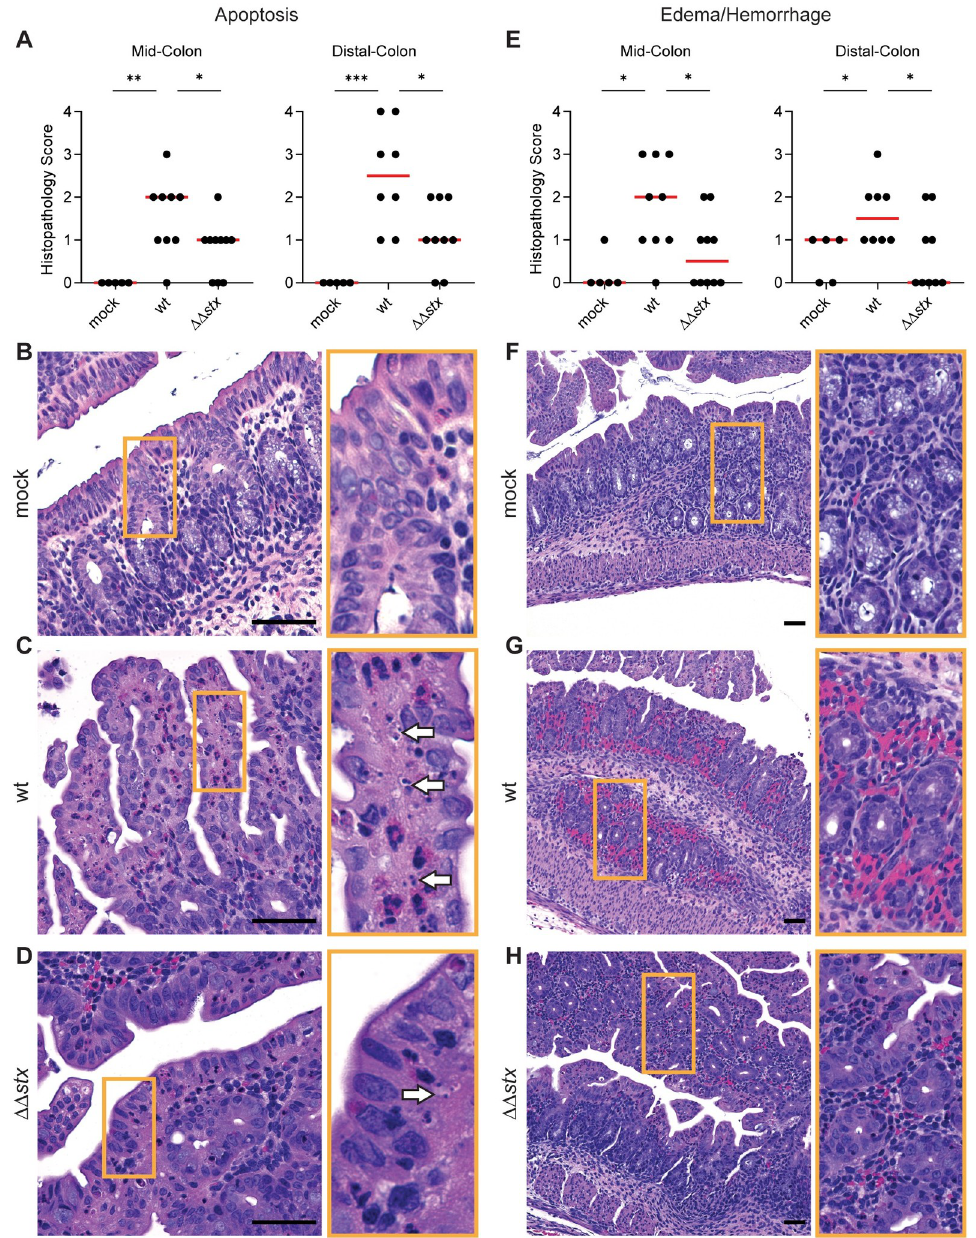
Fig 1. Apoptosis and hemorrhage/edema in the colon is more prominent in animals infected with WT vs ΔΔ stx EHEC. (A) Apoptotic nuclei in colon sections from infant rabbits inoculated with PBS (mock), WT or ΔΔ stx EHEC. Scores for individual animals are plotted with the median (red line). Statistical comparisons were made using a Mann- Whitney U, p < 0.05 ( � ), 0.01 ( �� ), or 0.001 ( ��� ). (B-D): Example images from mock (score = 0), WT (score = 4), and ΔΔ stx (score = 2) infected colons. White arrows indicate apoptotic nuclei. (E): Severity of hemorrhage/edema. (F-H): Representative example images from mock (score = 0), WT (score = 3) and ΔΔ stx (score = 1) infected colons. Scale bars indicate 50 μ m. Orange boxes denotes